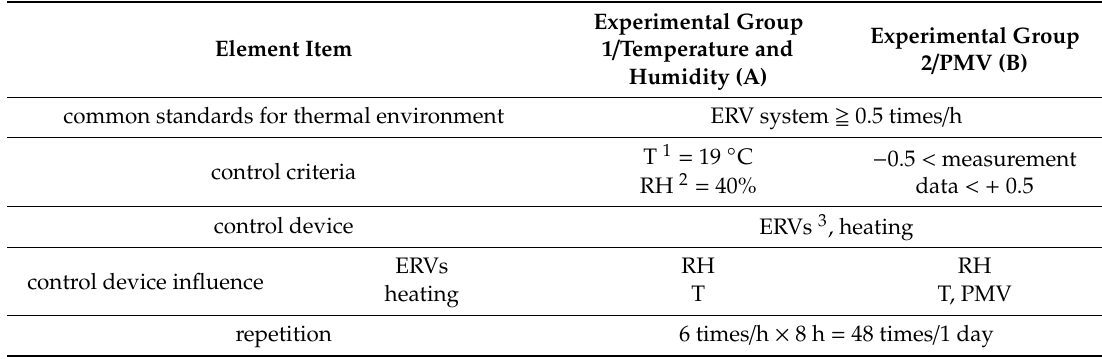
Table 1. Control criteria of the physical